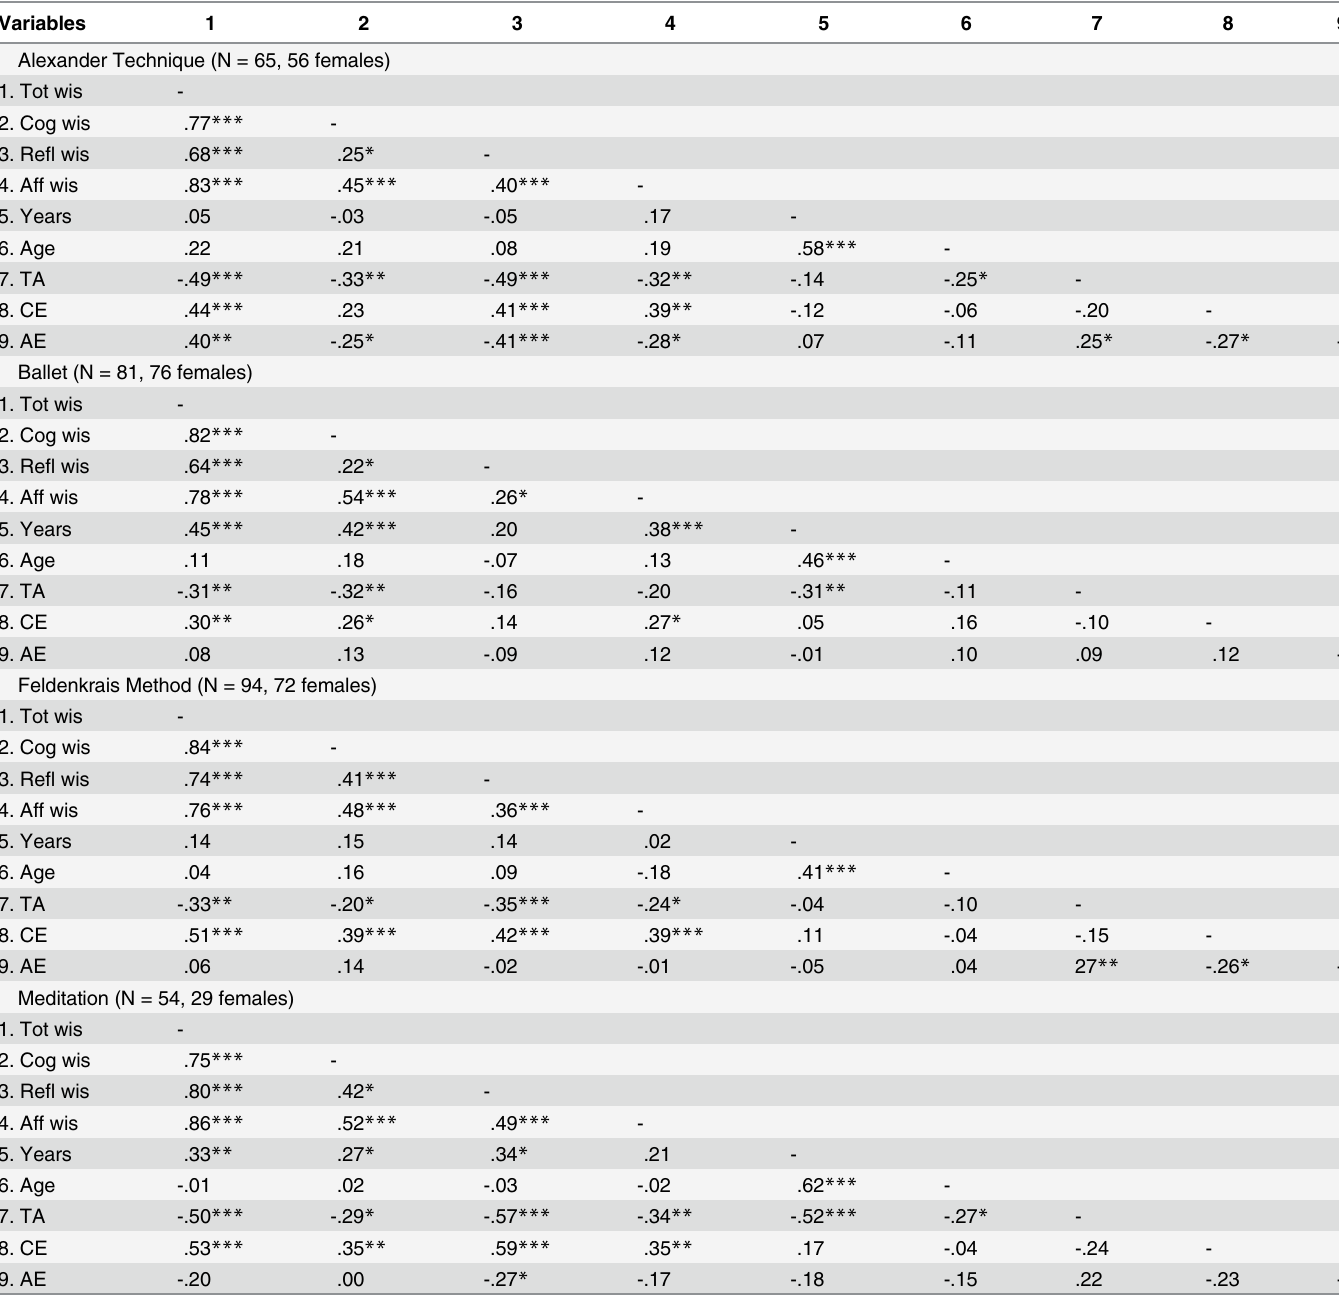
Table 3. Correlations among wisdom, its subcomponents, and predictor variables. Variables